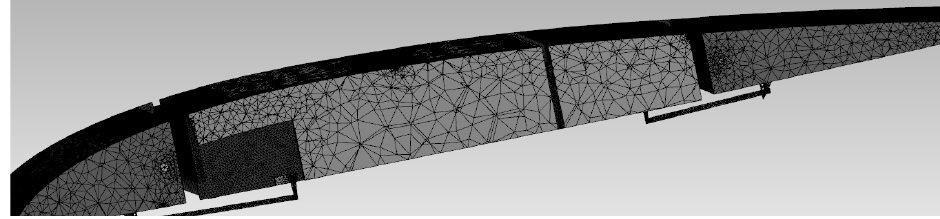
Figure 21. Mesh of the adaptive wing model.